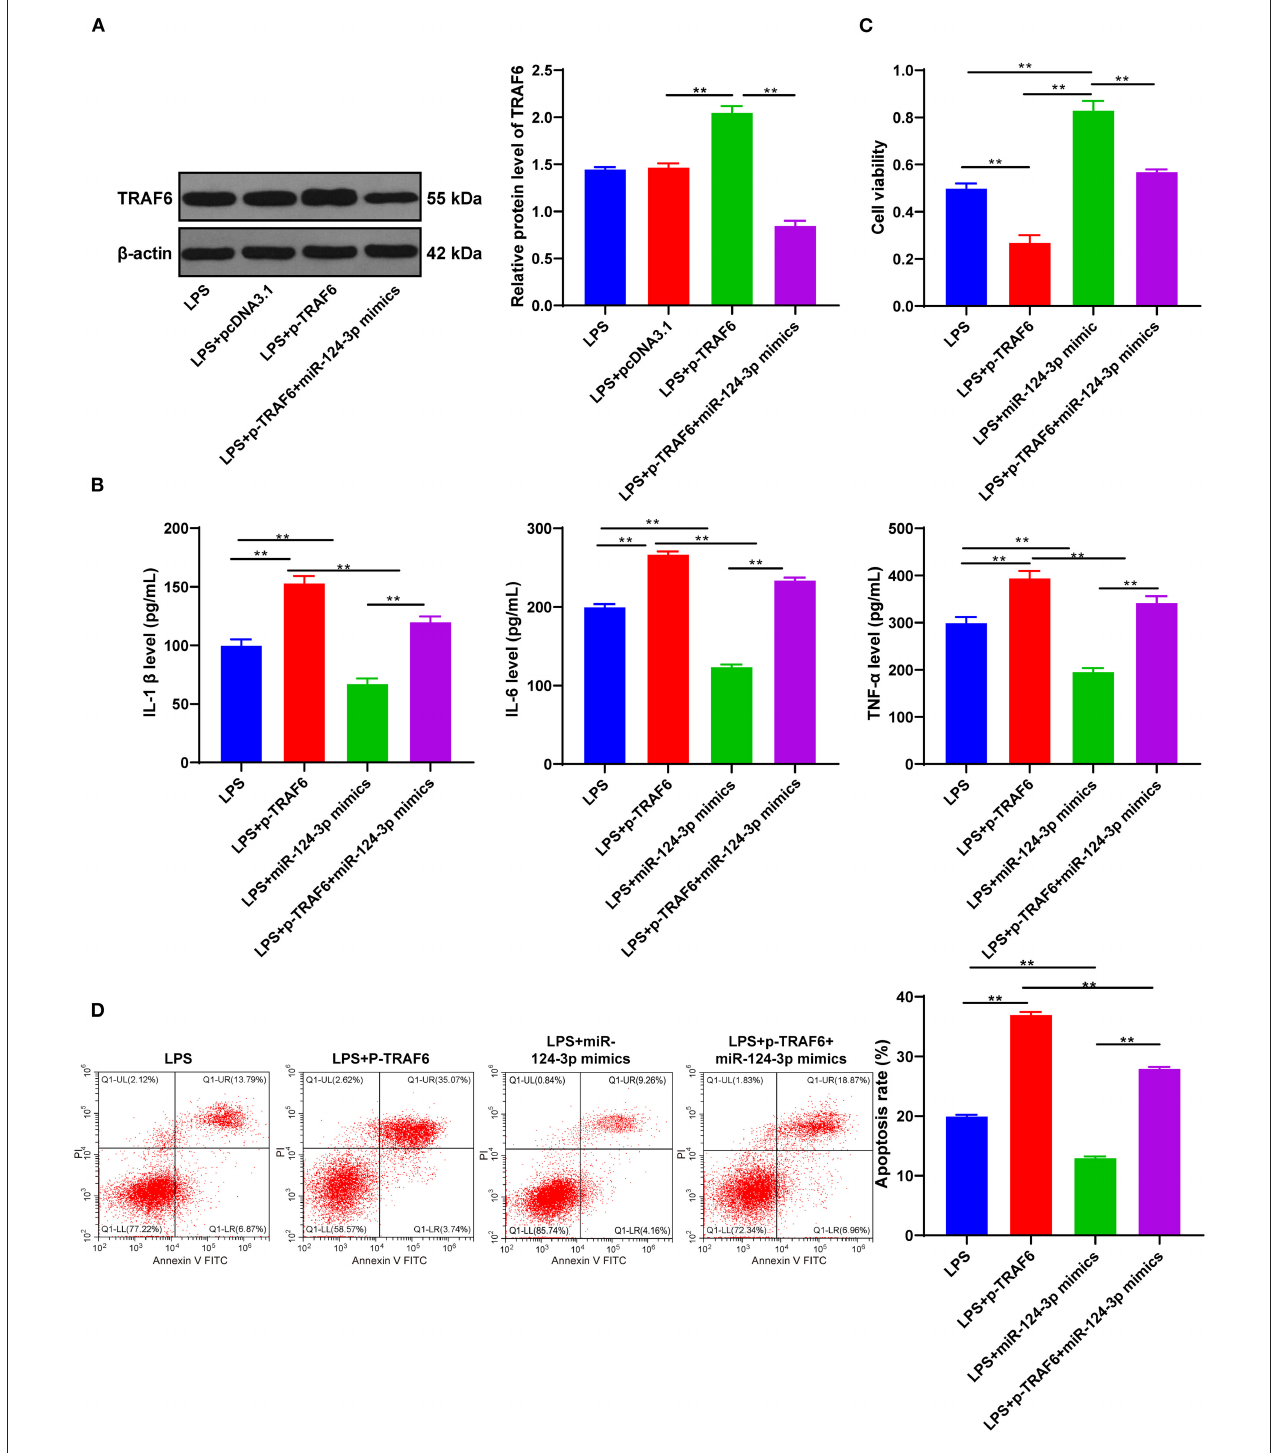
FIGURE 4 | miR-124-3p reduced inflammatory response by targeting TRAF6. (A) TRAF6 expression in untreated HMC3 cells, pcDNA3.1- or p-TRAF6-treated HMC3 cells was detected using Western blotting; (B) Inflammatory factors IL-1 β , IL-6, and TNF- α in p-TRAF6- or miR-124-3p mimic-transfected HMC3 cells induced by LPS were detected using ELISA; (C) Cell viability was detected using MTT; (D) Cell apoptosis was measured using flow cytometry. The cell experiment was repeated three times independently. Data are expressed as mean ± standard deviation and analyzed using one-way ANOVA, followed by Tukey’s multiple-comparison test, ** p <